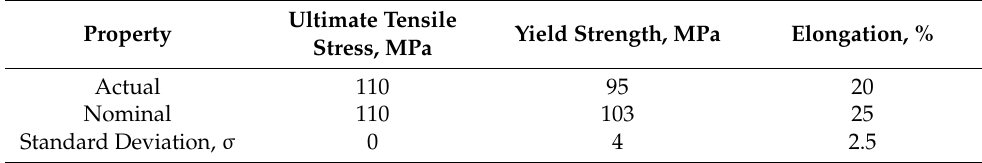
Table 1. Mechanical properties of the AA1100 aluminium alloy sheet.